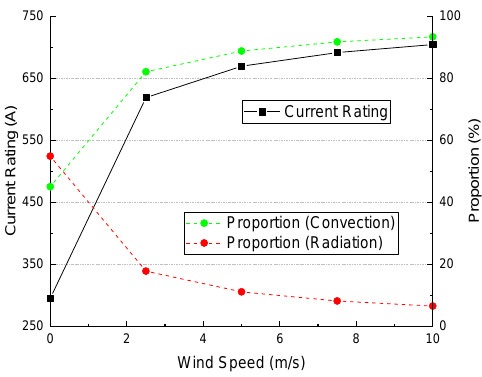
Figure 6. Ratings for different wind speeds.